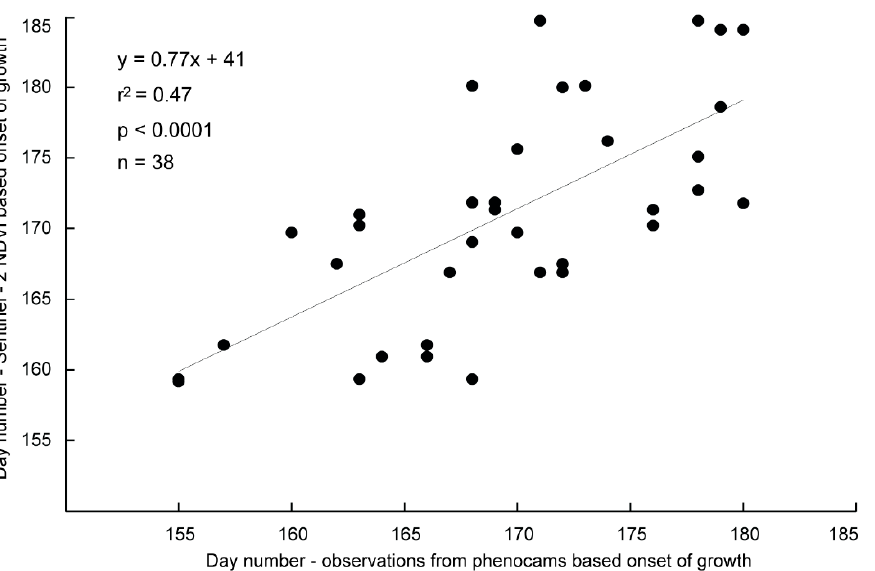
Figure 4. Relationship between the phenocam-based observations of onset of growth and the S2- NDVI-based onset of growth.